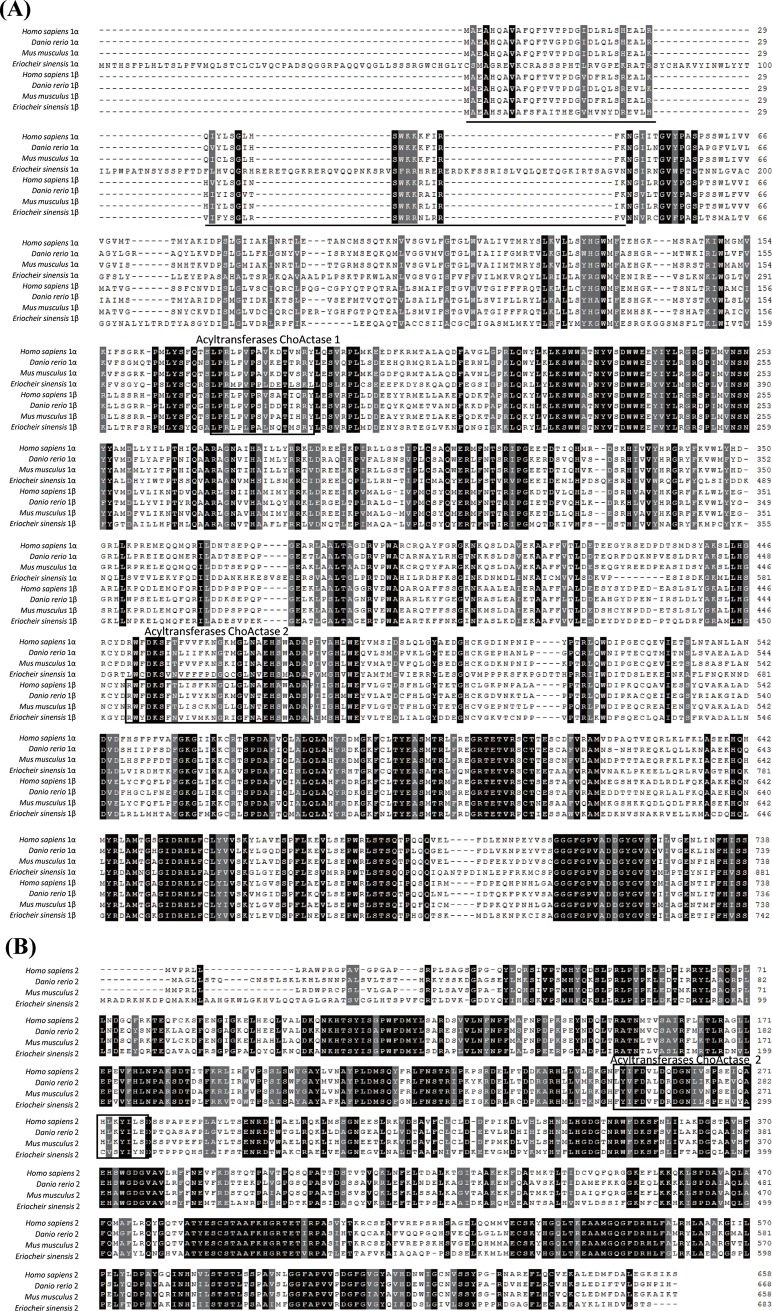
Alignment of the deduced amino acid sequences of carnitine palmitoyltransferase 1 (CPT 1; A) and CPT2 (B) from Homo sapiens, Danio rerio, Mus musculus and Eriocheir sinensis. Identical residues are shaded dark grey, and similar residues are shaded grey. CPT family proteins are predicted to include two key domains; the CPT N-terminal domain is underlined, and acyltransferase choActase domains 1 and 2 are boxed.